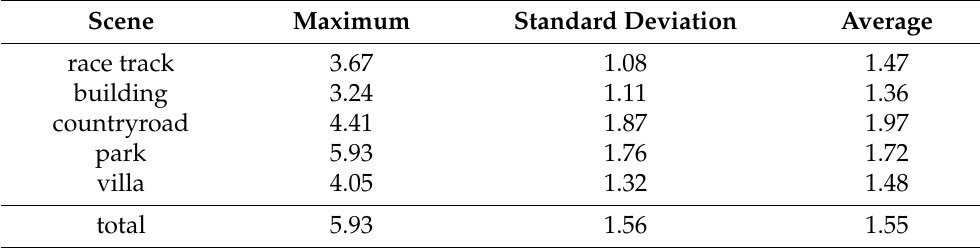
Table 5. Re-projection error(px) of manual tie